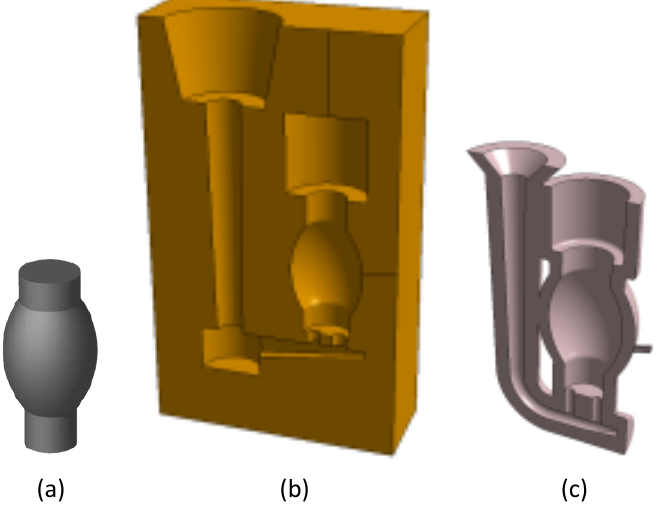
Figure 2. ( a ) Casting part CAD, ( b ) sand mould CAD, ( c ) 3DP mould CAD.